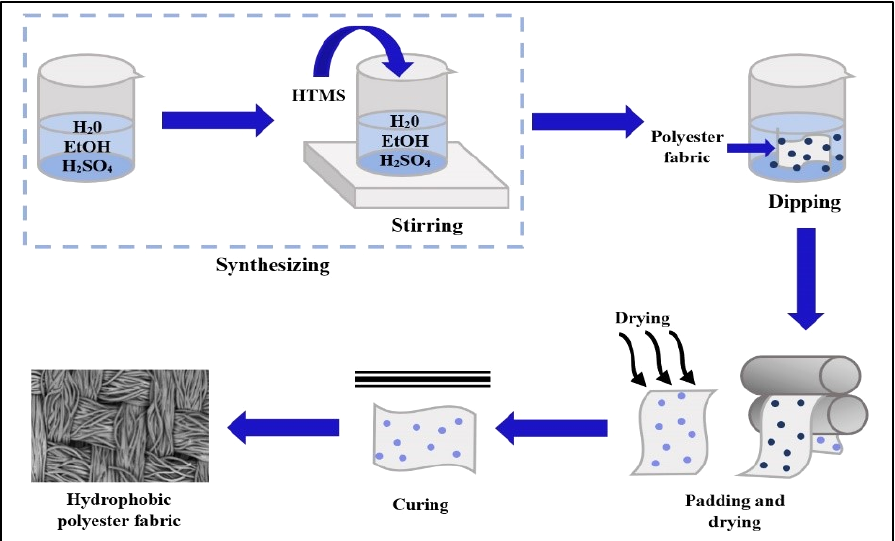
Figure 1. Synthesizing process of HTMS sols and treatment of polyester